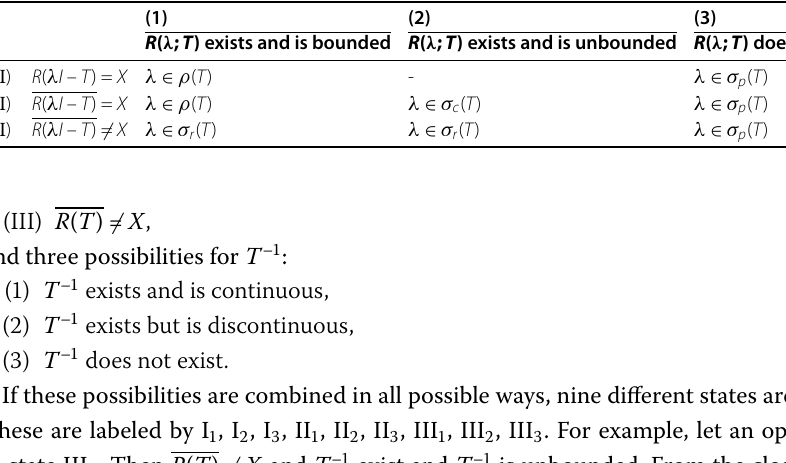
Table 1 Goldberg’s decomposition of the spectrum (1)